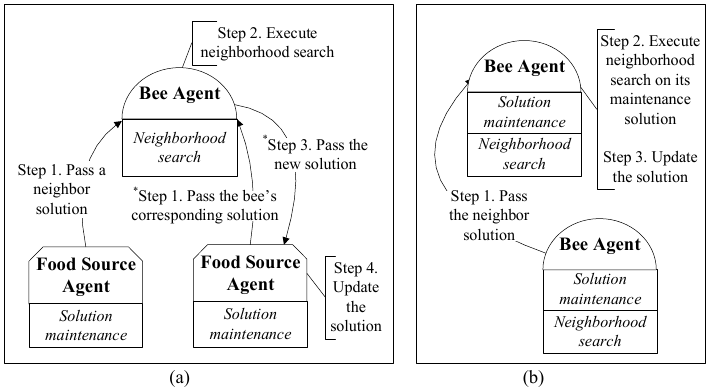
Figure 4. The major steps in generating a new solution. ( a ) The approach reported in [17] and ( b ) an improved version of ( a ). The steps labeled with * in ( a ) are redundant with ( b ).